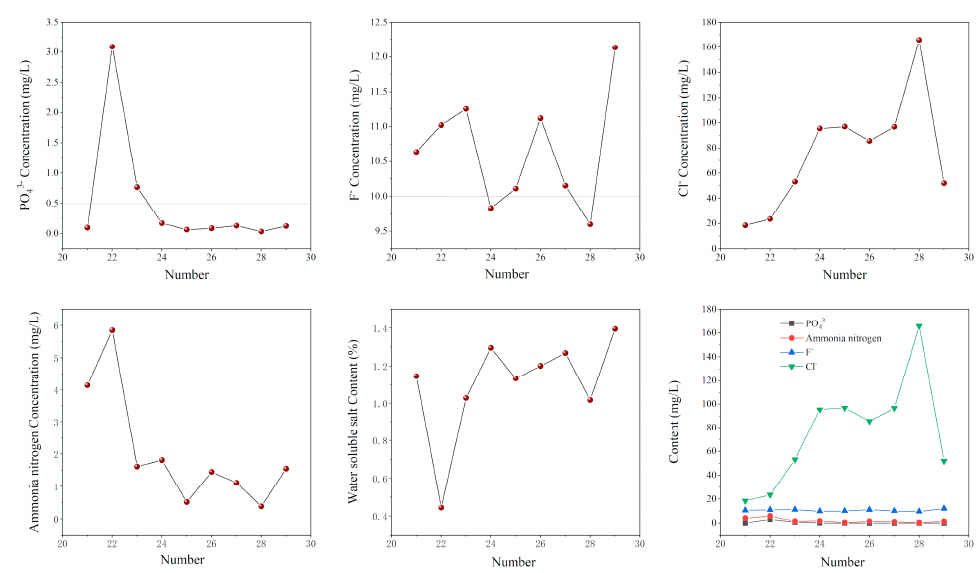
Figure 11. The concentration of P, F, Cl, ammonia nitrogen and water-soluble salt.